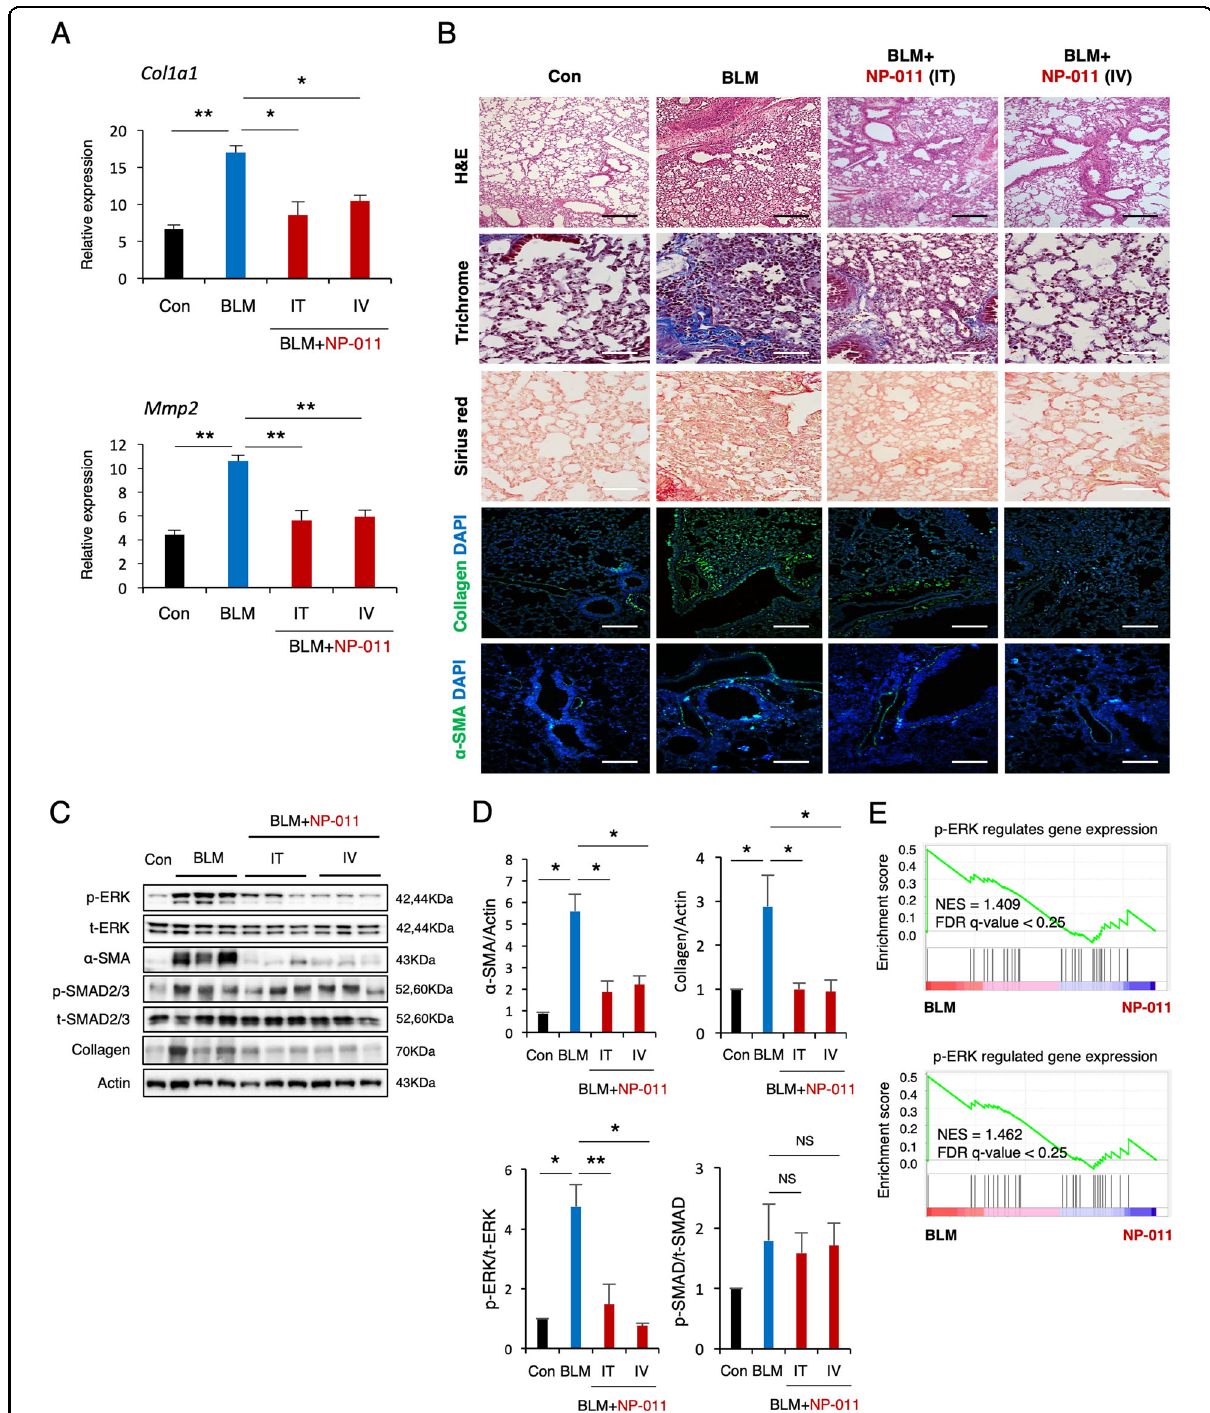
Fig. 2 NP-011 reversed existing PF via suppression of ERK signaling. A The mRNA levels of Col1a1 and Mmp2 in lungs from the indicated groups of mice were detected by qPCR. B Representative images show H&E, Masson ’ s trichrome, Sirius red, Collagen, and α -SMA staining of lung sections from the indicated groups of mice. Scale bars, 100 μ m. C , D Western blotting ( C ) and subsequent quanti fi cation of p-ERK, p-SMAD2/3, α -SMA, and Collagen ( D ) in whole-lung homogenates of mice from the indicated groups. Actin was used as a loading control. NS indicates a nonsigni fi cant difference. E Two different GSEA data showing the signi fi cant suppression of non-canonical ERK signaling gene sets in NP-011-administered group compared to BLM-treated group in PF model. Data are presented as means ± SD; n = 10 (control), n = 11 (BLM), n = 5 (BLM + NP-011 IT), n = 7 (BLM + NP-011 IT). * p < 0.05, ** p < 0.01